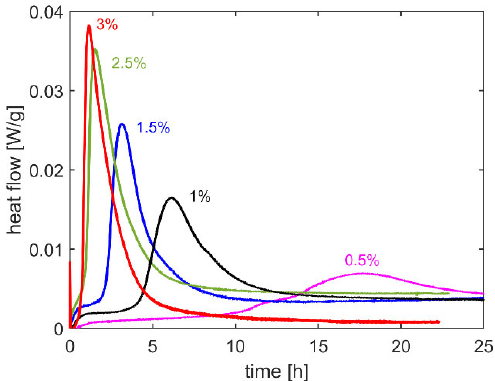
Figure 2. DSC curves of UPR–MEKP mixture for different MEKP/UPR weight ratios. Table 1. Heat of cure calculated from the DSC curves and the degree of cure normalized with respect to the heat of cure of mixture with 3% initiator (table shows mean values. Only for 1.5%, ± one standard deviation is also given, as 3 specimens were tested at that ratio). Initiator/Resin Weight Ratio Heat of Cure [J/g]